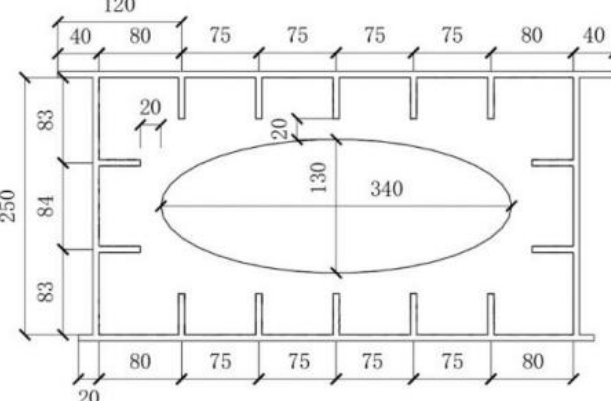
Figure 3. Cross-sectional dimension of the specimen/unit: mm.